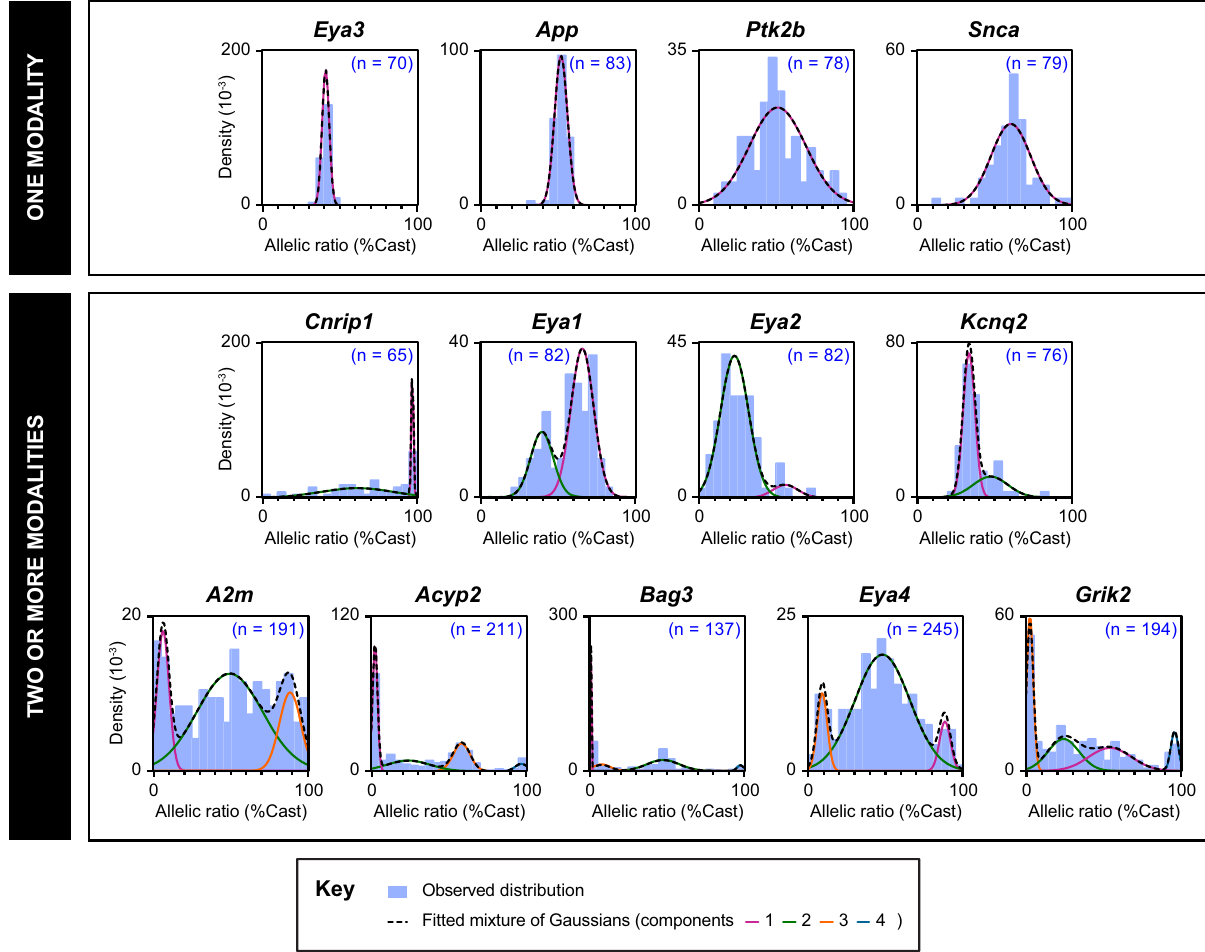
Fig. 2 Gene-speci fi c modalities of allelic expression. The distributions of allelic expression ratios in NPC clones are represented as density histograms for the 13 genes of interest. n is the number of NPC clones analysed for each gene. The observed distributions are modelled with Gaussian mixtures. The genes were classi fi ed according to the number of subpopulations, computed using the BIC criterion (Supplementary Fig.